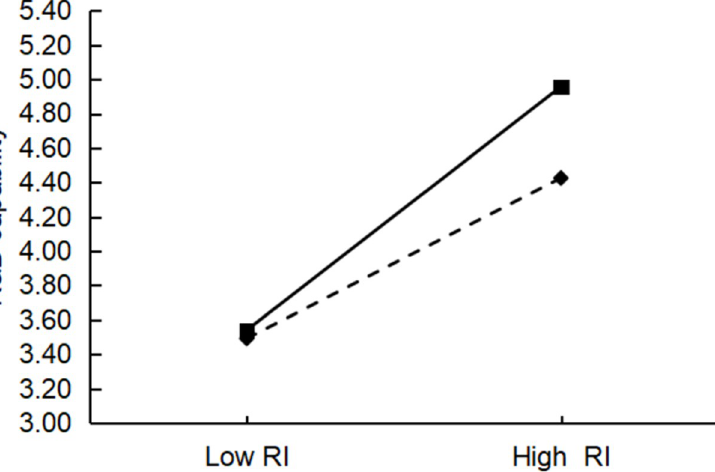
Fig 3. Test of the moderating effect of absorptive capacity differences on resource interaction and R&D capabilities. The dashed line represents low absorptive capacity differences while the solid line represents high absorptive capacity differences (same below).